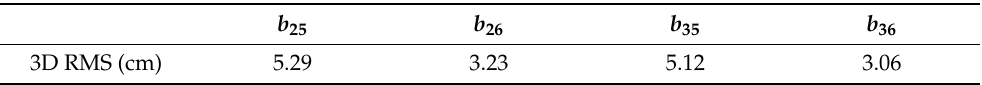
Table 8. 3D RMS positioning errors of the baselines across the two cells with the proposed framework using 6 common satellites in view in Figure